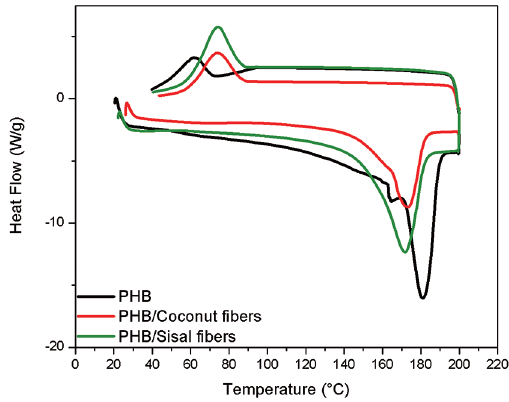
Figure 4: DSC curves of the post-molding PHB and composites PHB/coconut fibers and PHB/Sisal fibers. (Figure 4) showed a decrease compared to PHB before processing, which showed a value of approximately 86°C (Figure 2). The DSC curves for temperatures up to approximately 325 °C (Figure 5) were carried out for the post-molding PHB and